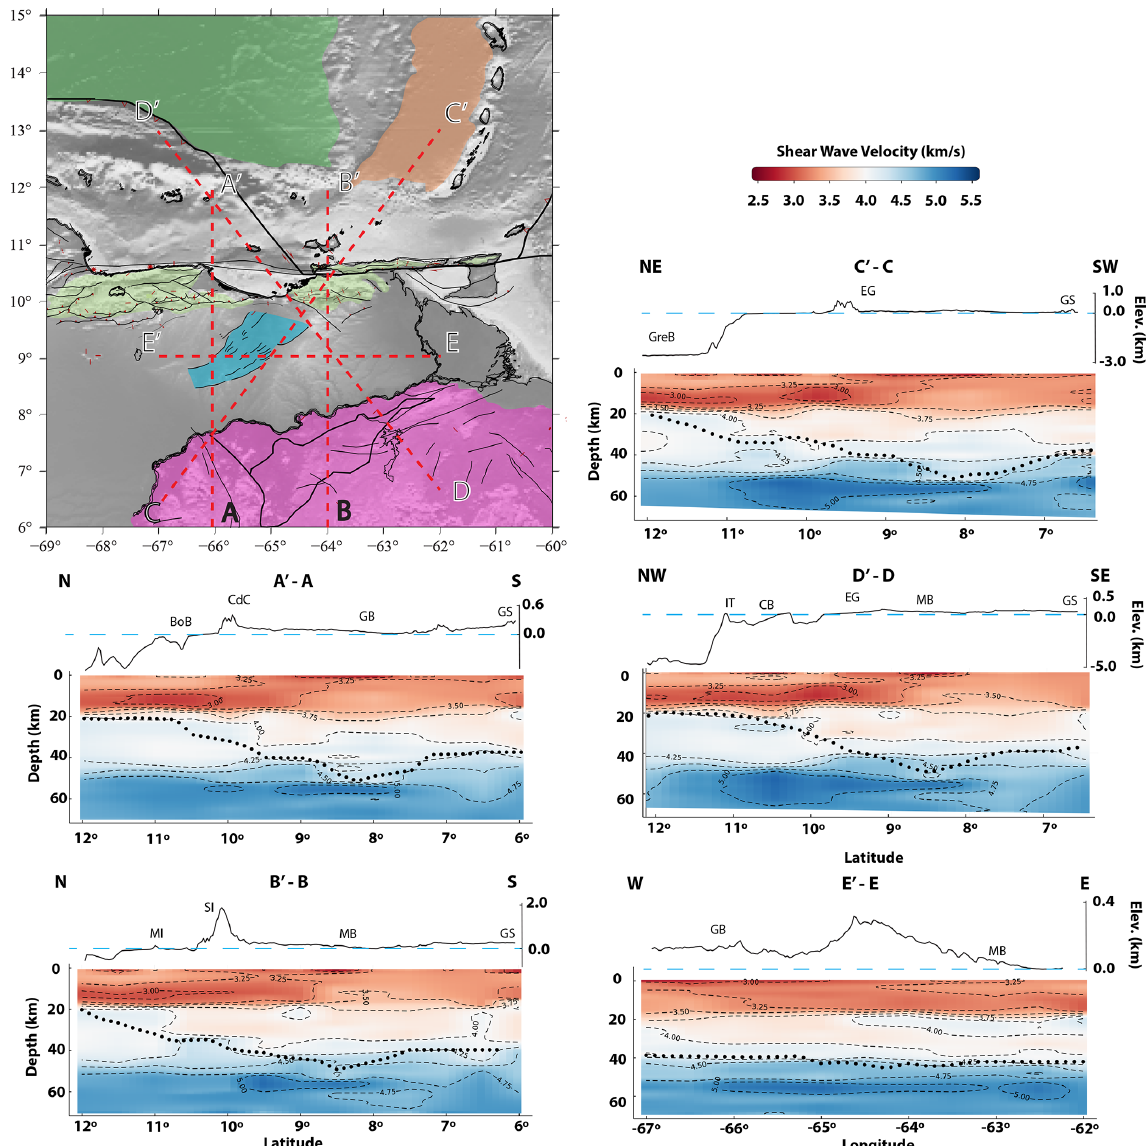
Figure 11. Profiles show the V s variations across the studied area. On the top left is a map displaying the location of each profile. Each profile shows the V s structure of the final model and the Moho depth (dotted black line) interpolated with the nearest neighbor algorithm. On the top is the topography and bathymetry from GEBCO 2021 (dashed blue line is 0ma.s.l.). Contours every 0.25kms − 1 . In thin black lines we show active faults as presented by Audemard et al. (2006). Abbreviations are BoB (Bonaire Basin), CdC (Cordillera de la Costa), GB (Guárico Basin), GS (Guiana Shield), MI (Margarita Island), SI (Serranía del Interior), MB (Maturín Basin), IT (Isla La Tortuga), CB (Cariaco Basin), EG (Espino Graben) and GreB (Grenada